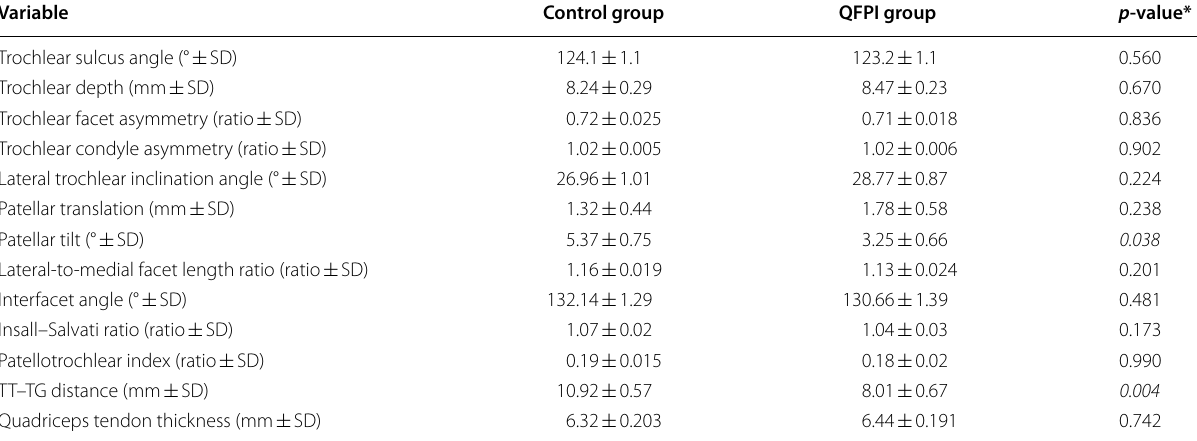
*Mann–Whitney U test. Italic p values are